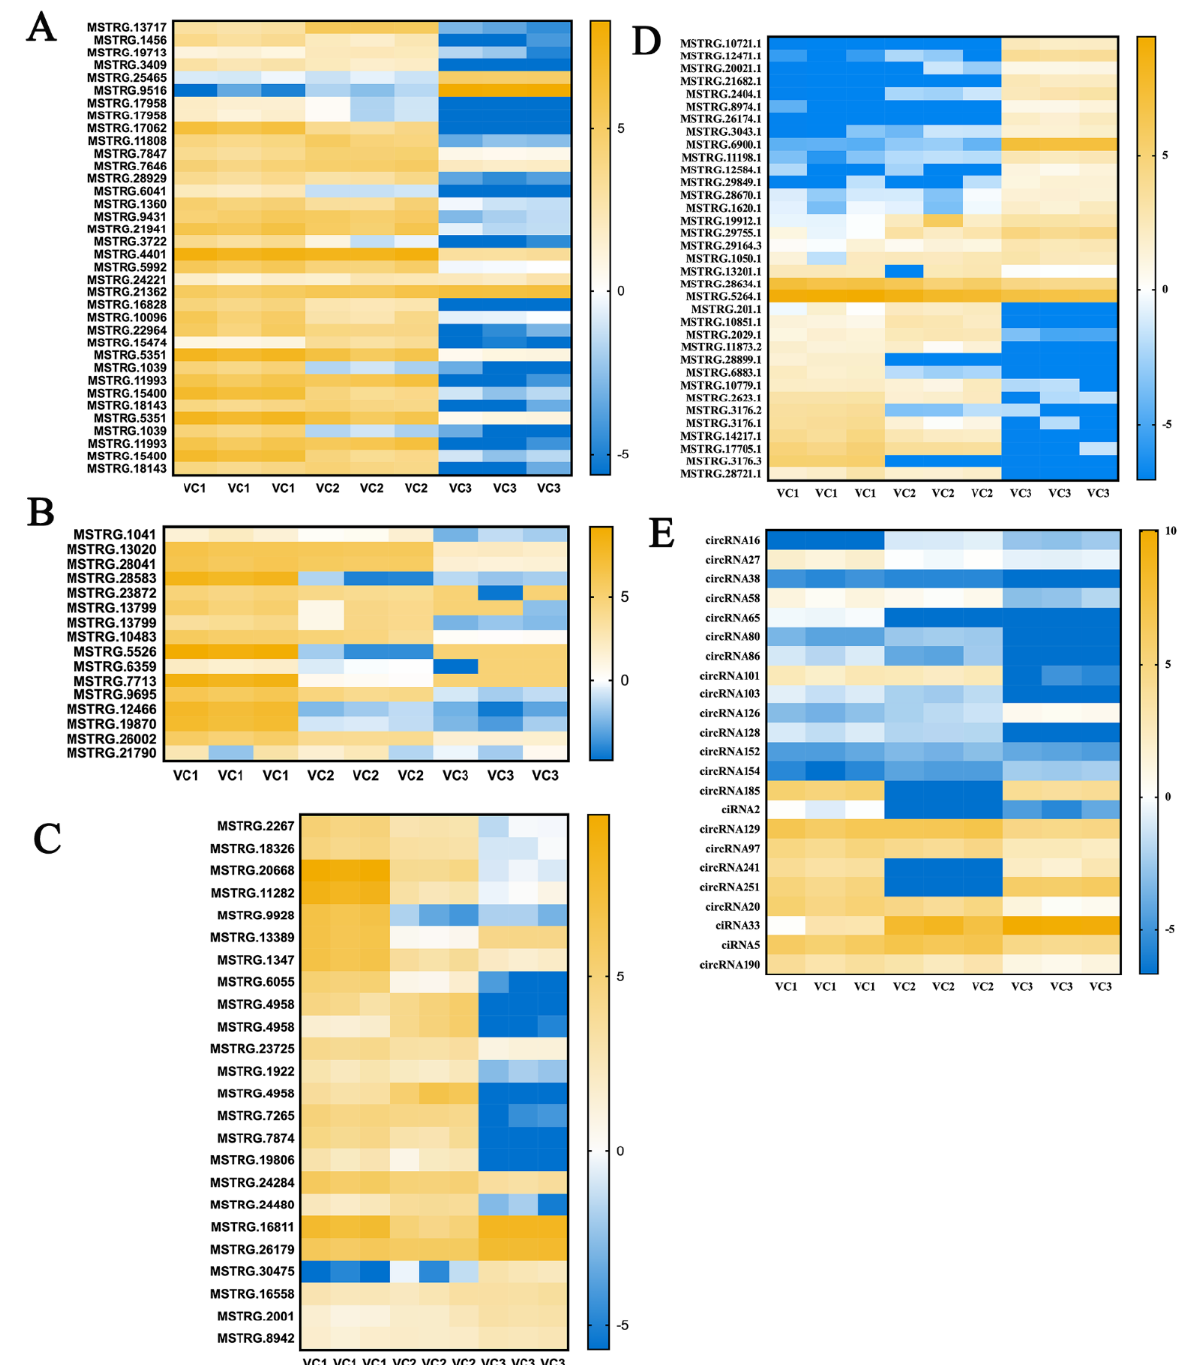
Figure 5. The analysis of differentially expressed genes and non-coding RNAs. ( A ) The differentially expressed genes of phytohormone signal transduction, ( B ) starch and sucrose metabolism, and ( C ) phenylpropanoid biosynthesis. ( D ) The differentially expressed candidate lncRNAs that interacted with the miRNAs and mRNAs. ( E ) The differentially expressed candidate circRNAs that interacted with the mRNAs and miRNAs. Different colors denote different expression levels, with white representing low expression and blue representing high expression. The values beside the colors represent log 2 (FPKM +